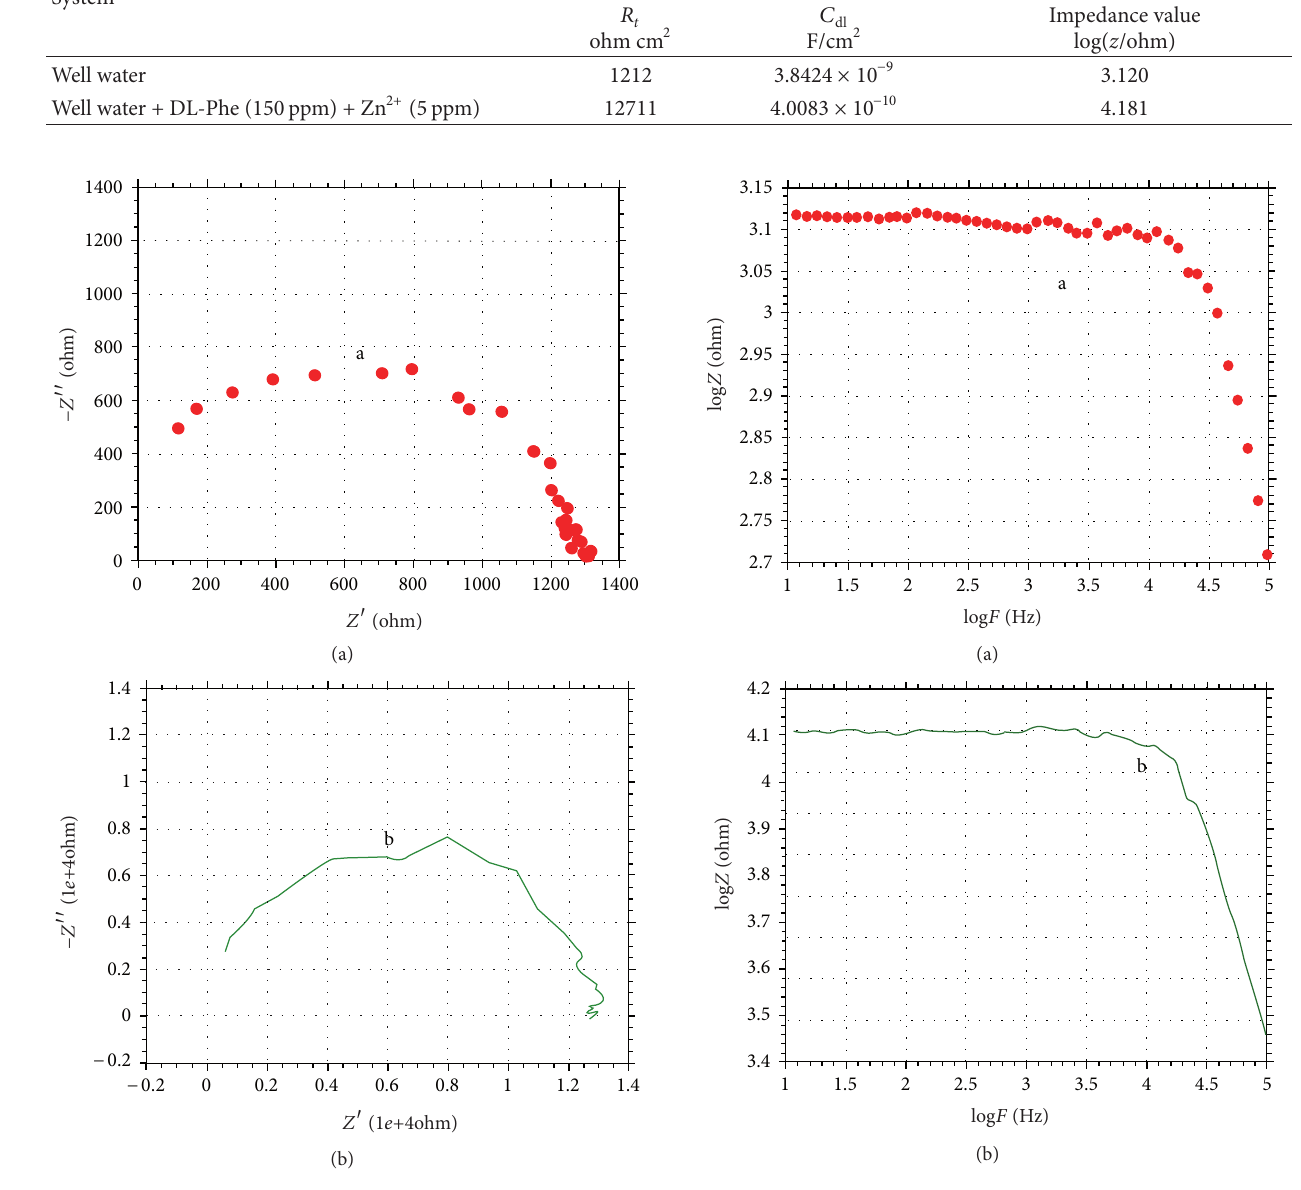
F 3: AC impedance spectra of carbon steel immersed in test (5ppm). 2+